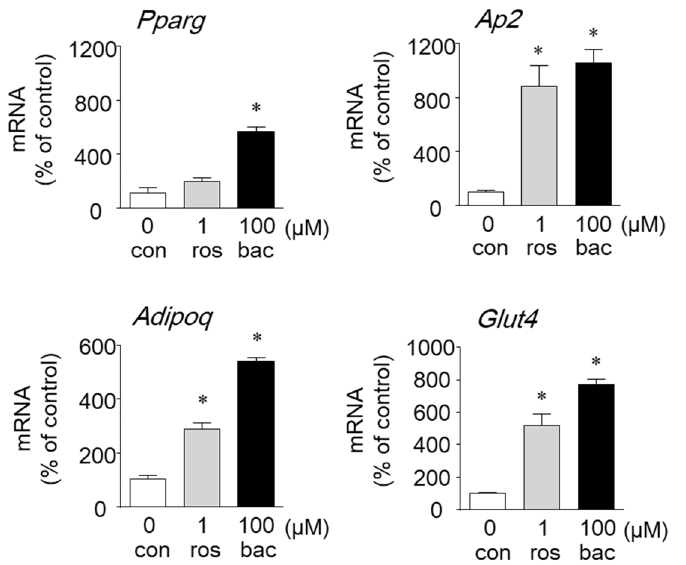
Figure 5. Effect of baccharin on the mRNA expression of genes related to adipocyte differentiation. In the presence of insulin (1 µg/mL), 3T3-L1 preadipocytes were cultured with rosiglitazone (ros: 1 µM) or baccharin (bac: 100 µM). Total RNA was isolated, and cDNA was synthesized. The mRNA expression of each gene was determined by real-time RT-PCR. Values are expressed as means ± SEM ( n = 3). * p < 0.05 compared with the control (con) in the presence of insulin.